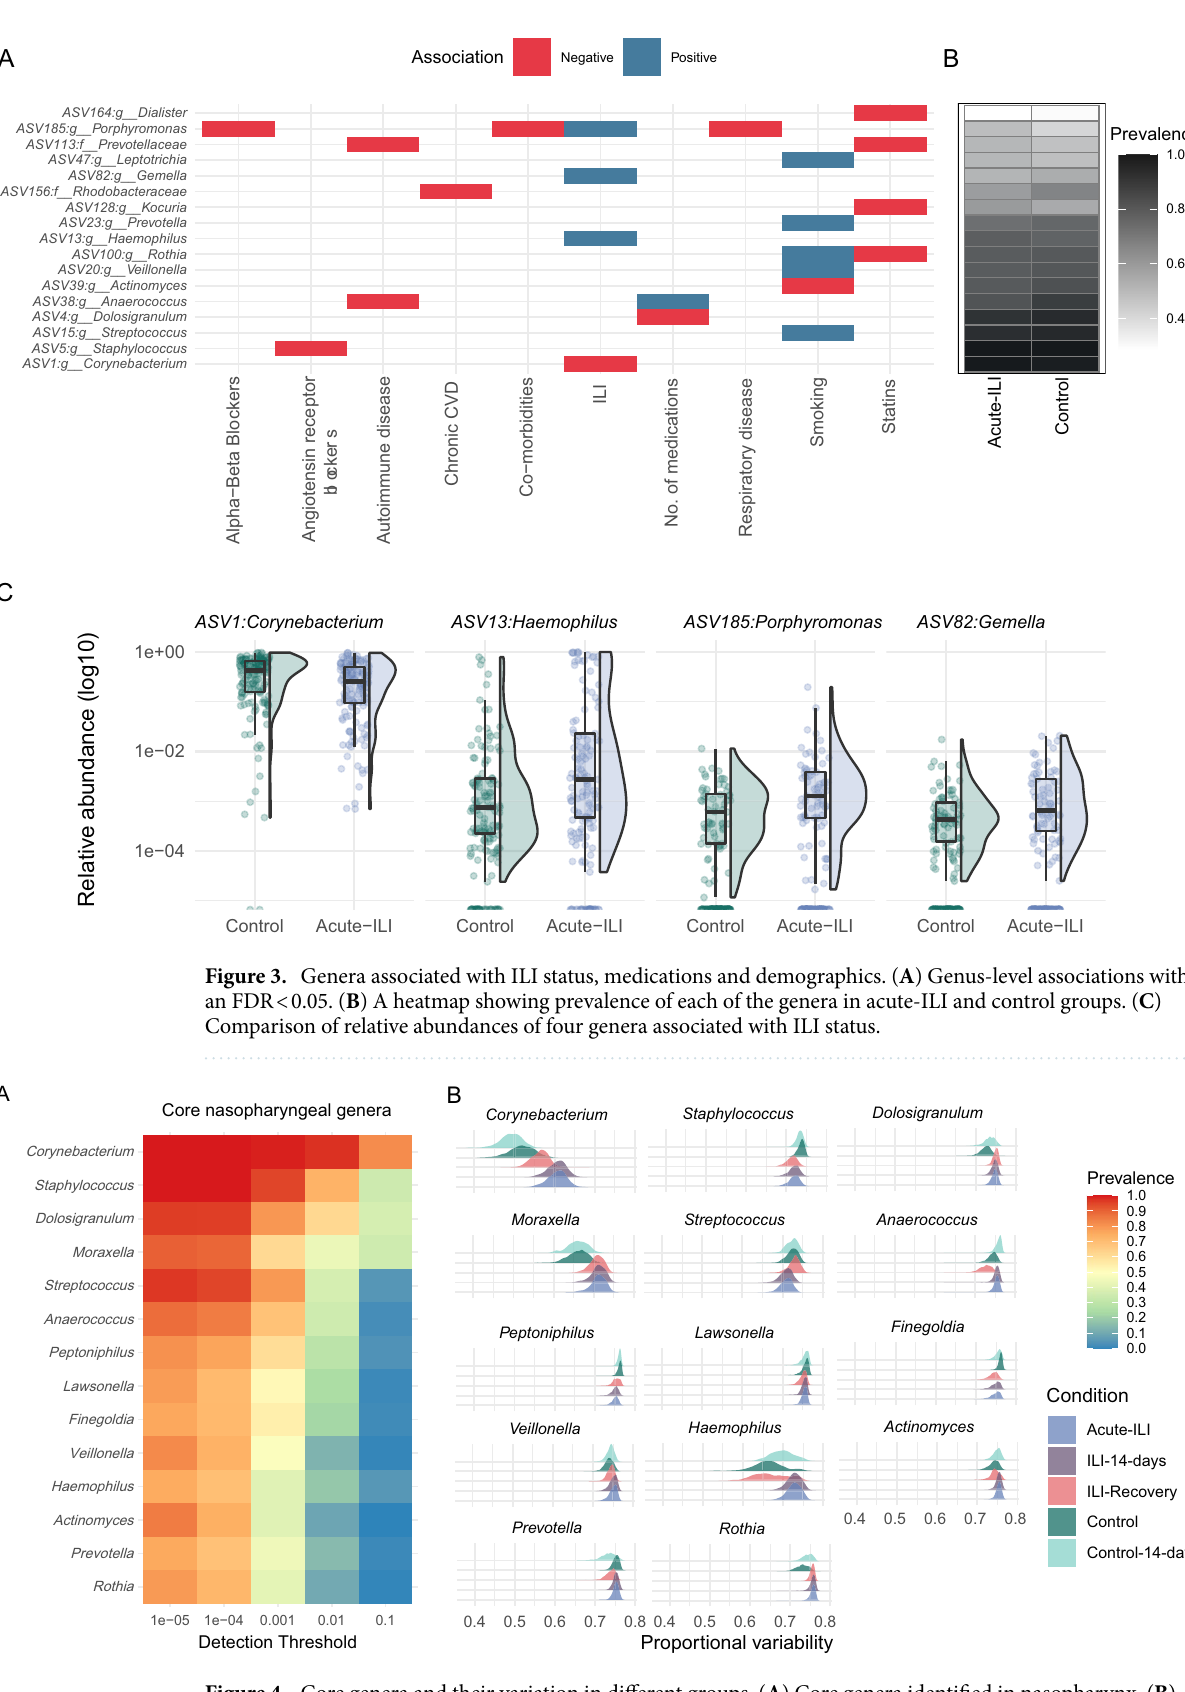
Figure 4. Core genera and their variation in different groups. ( A ) Core genera identified in nasopharynx. ( B ) Distribution of proportional variability values for each core genera within each group based on 999 bootstrap